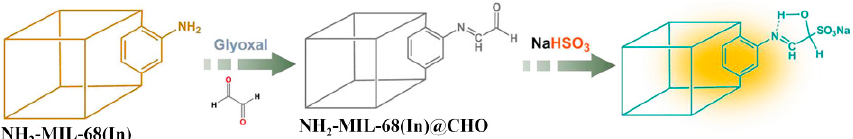
Figure 13. The synthesis of NH 2 -MIL-68(In)@CHO and its sensing process for bisulfite. Reproduced with permission from [103]. Copyright Elsevier B.V., New York, NY, USA, 2018.